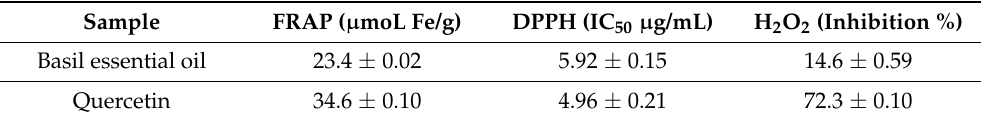
Table 2. Antioxidant potential of O. basilicum essential oil.